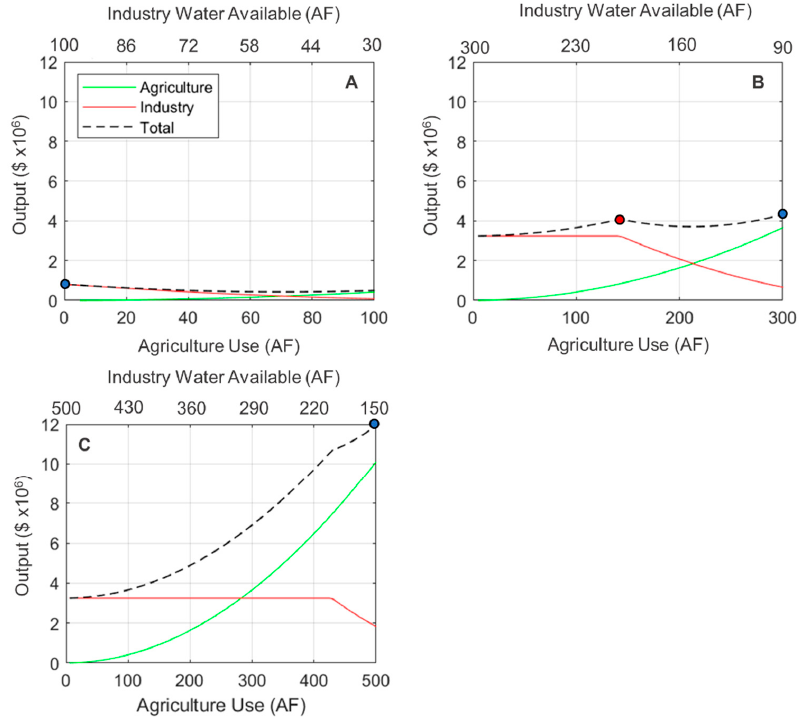
Figure 2. Comparison of water allocation between agriculture and industry and total economic output, for total water availability varying from ( A ) 100 AF to ( B ) 300 AF to ( C ) 500 AF. Lower x -axis shows upstream agricultural use; upper x -axis shows remaining water available for downstream industrial use, given the agricultural use and return flows. Horizontal portion of industrial output curve shows the extent of maximum industrial output. Maximum output economy-wide (blue dots) is achieved for different relative allocations of water depending on the total water available. Note differences in x -axis between